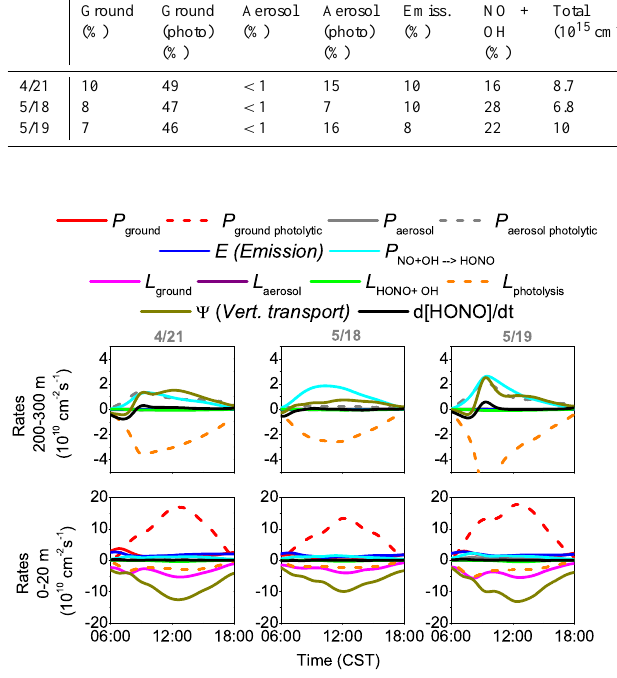
Fig. 9. Vertical profiles of the modeled HONO formation and loss pathways in the lowest 300m at noon on 21 April, 18 May, and 19 May. The vertical transport term describes how much HONO is added or removed by vertical transport at each altitude.